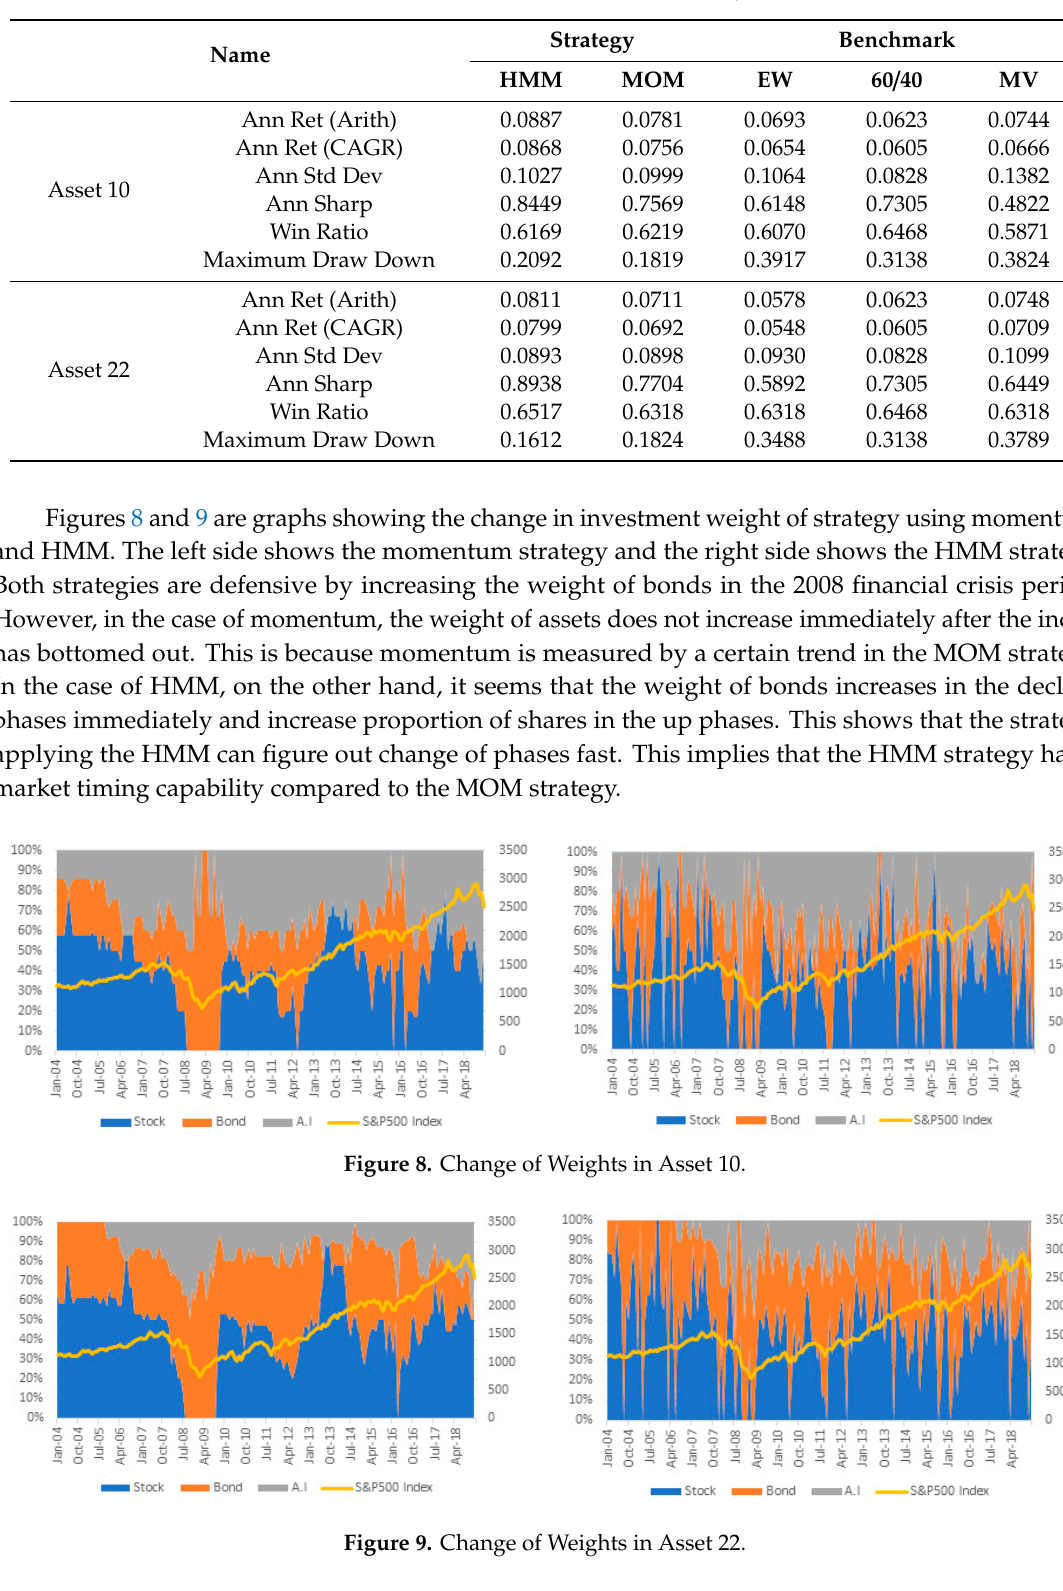
Table 4. Portfolio Performance Summary.